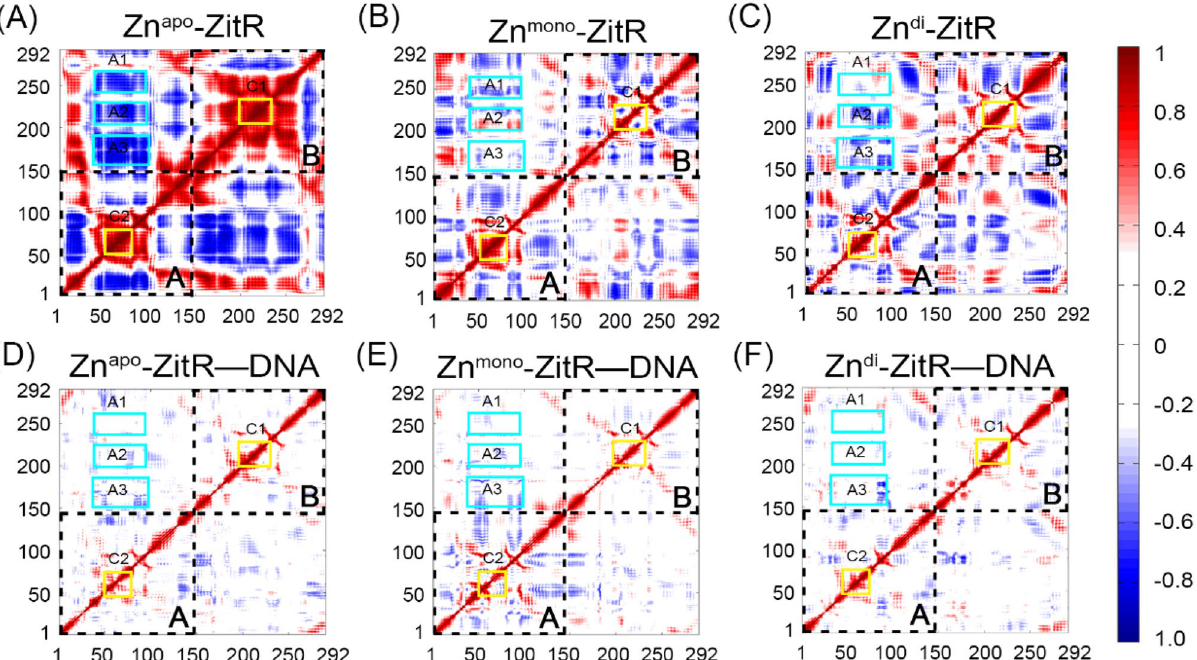
Figure 2. The dynamic cross-correlation matrixes (DCCM) of the six systems: Zn apo –ZitR ( A ), Zn mono –ZitR ( B ), Zn di –ZitR ( C ), Zn apo –ZitR–DNA ( D ), Zn mono –ZitR–DNA ( E ), and Zn di –ZitR–DNA ( F ). Areas of chains A and B are separated by dashed lines. Red and blue express correlations and anticorrelations, respectively. Yellow rectangles show areas with obvious correlations, while cyan rectangles show areas with obvious anticorrelations. The interactions possessing an absolute correlation coefficient of less than 0.3 are neglected for